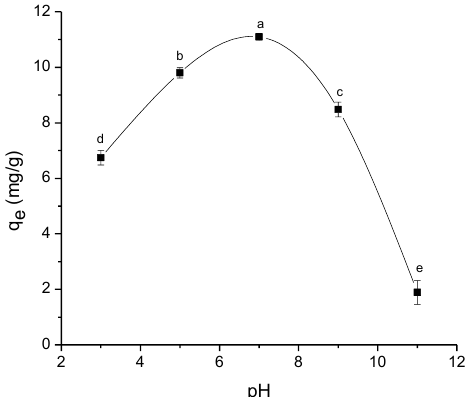
Figure 7. The effect of solution pH on the sorption of enrofloxacin onto P. koidzumii sorbent (adsorbent dose 8 g/L; 100 mg ENR/L; contact time 40 min; and temperature 298 K). Those means that do not share a common superscript differ significantly (Tukey p < 0.05).